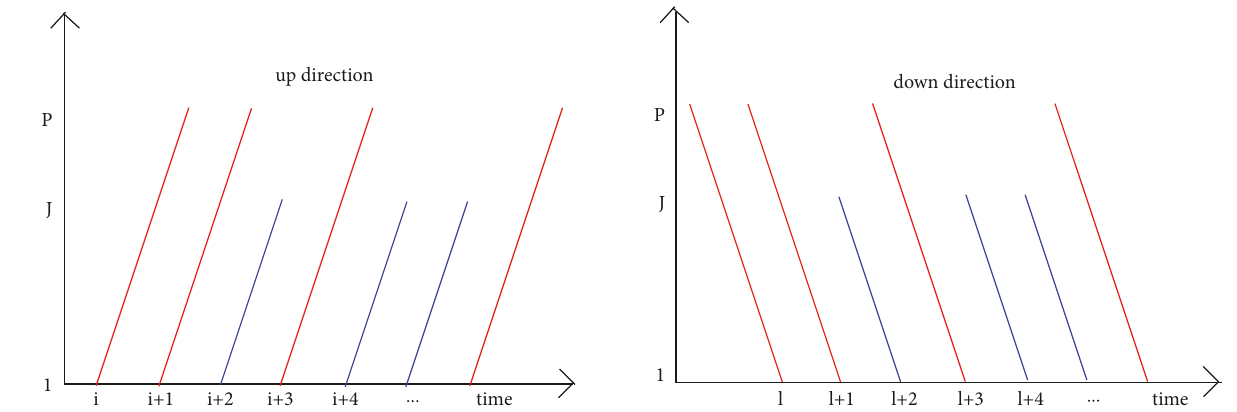
Figure 8: The order of train services in the up and down